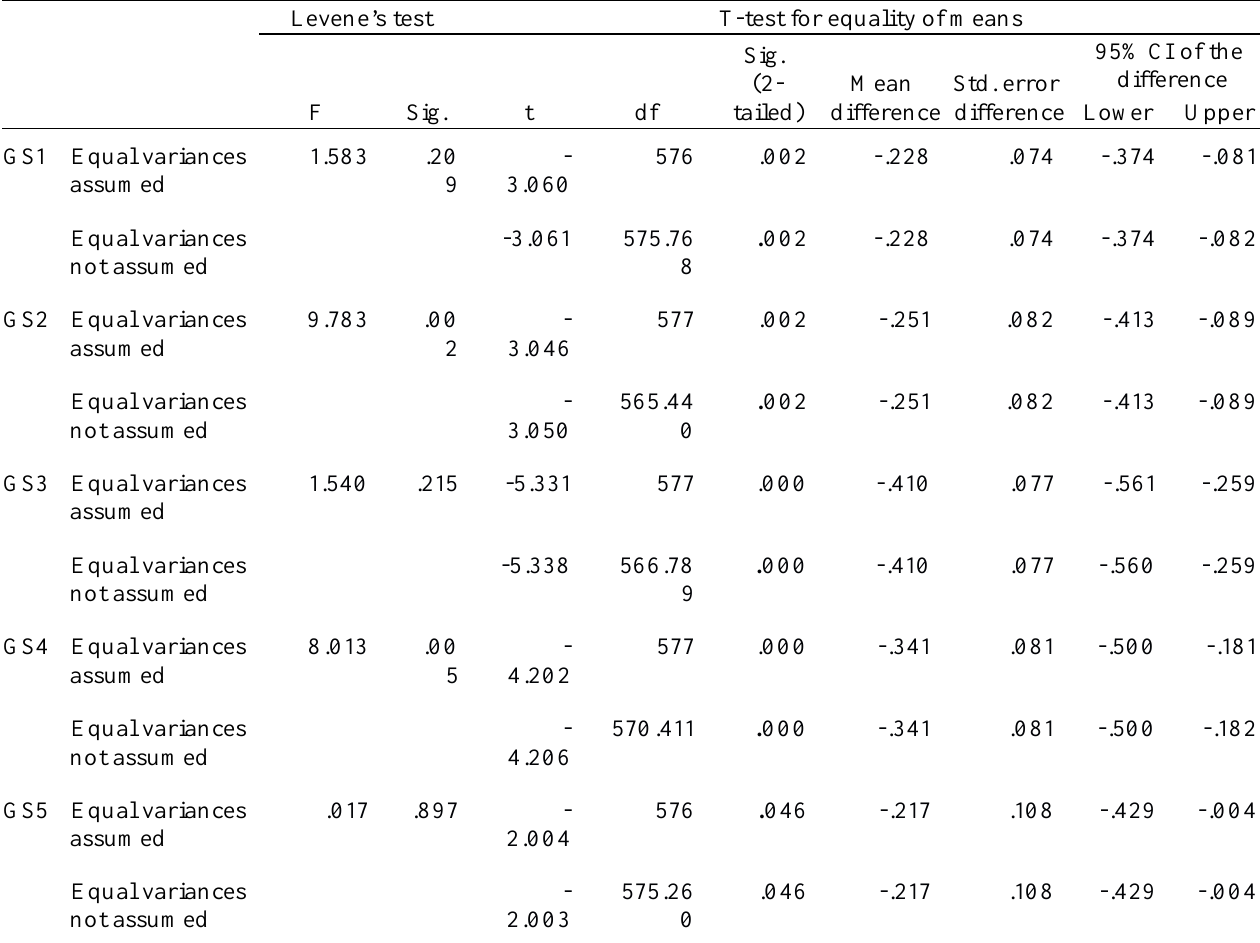
Table 4 Results of Multiple T-Tests for the Items in Goal Setting and Environment Structuring